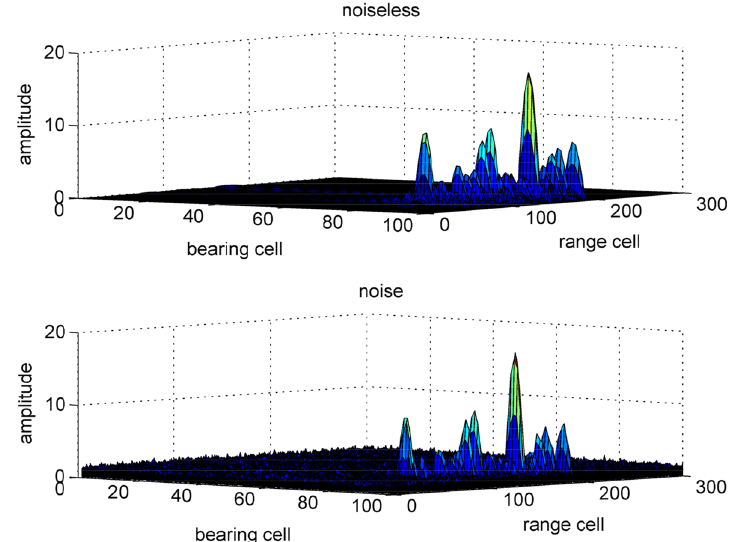
Fig. 2 The target amplitude fluctuation schematic. Top: Noiseless. Bottom: SNR